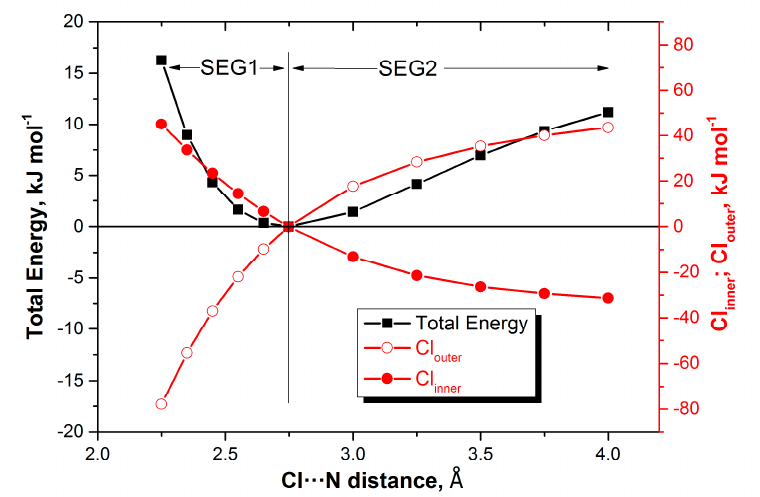
Figure 2. Energy profiles (total system, total atomic Cl outer and total atomic Cl inner ) of H 3 N:Cl 2 as a function of the distance between the “inner contact atoms” Cl inner and N 3 . The three energies all refer to the corresponding energies at equilibrium, referring to the respective energy scales (left = total system, right = atomic energies).